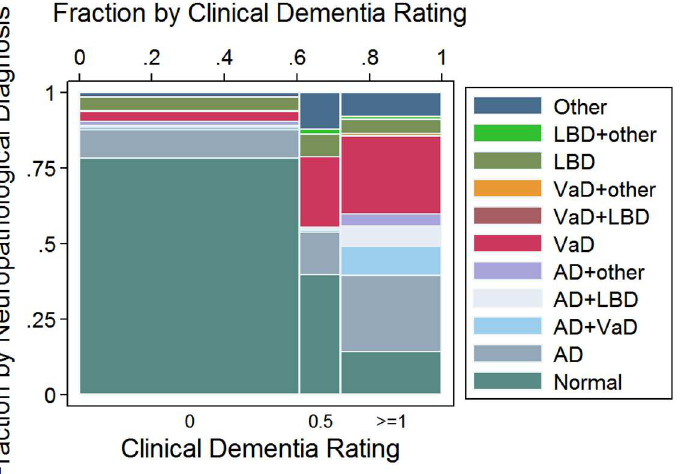
Fig 1. Mosaic plot showing the relationship between neuropathological classification and dementia status according to the Clinical Dementia Rating (CDR) scale: CDR = 0: No dementia; CDR = 0.5: Questionable dementia; And CDR (cid:21) 1: Dementia. AD, Alzheimer disease;LBD, Lewy body disease;VaD, vascular disease.